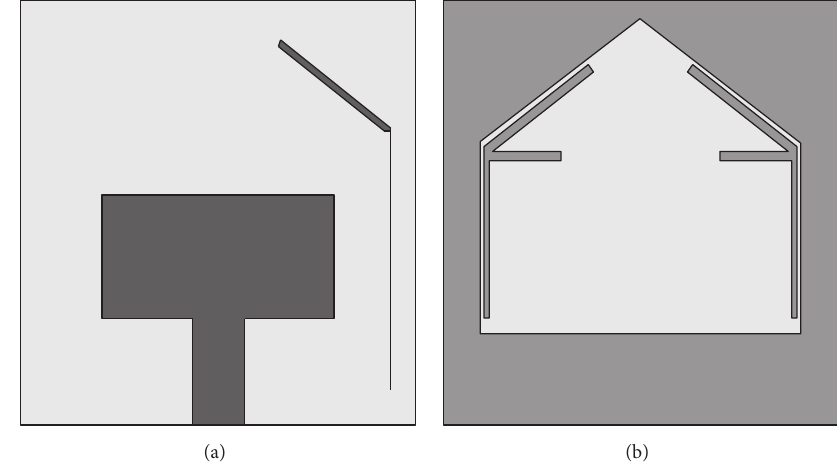
Figure 54: Geometry of the dual-band-notched UWB slot antenna [64]. (a) Front view. (b) Back view. The slits adopted to realize band- notched characteristics are indicated. Dark gray upper metal face, medium gray bottom metal face, and light gray dielectric